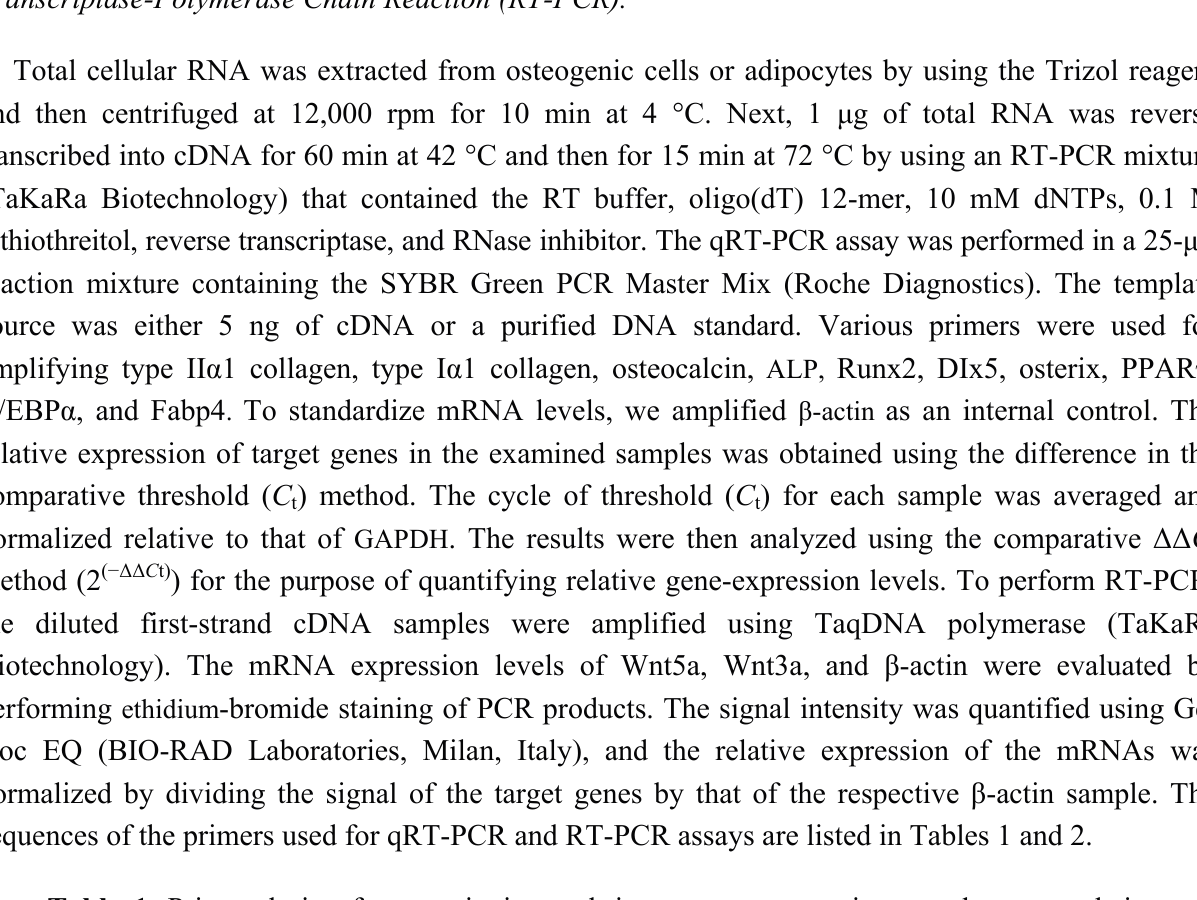
Table 1. Primer design for quantitative real-time reverse transcriptase-polymerase chain reaction (qRT-PCR)